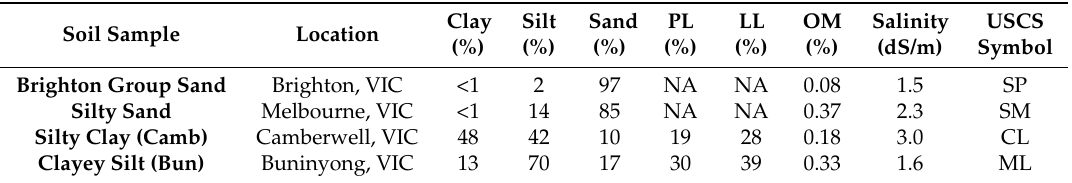
Table 1. Characterisation of soil